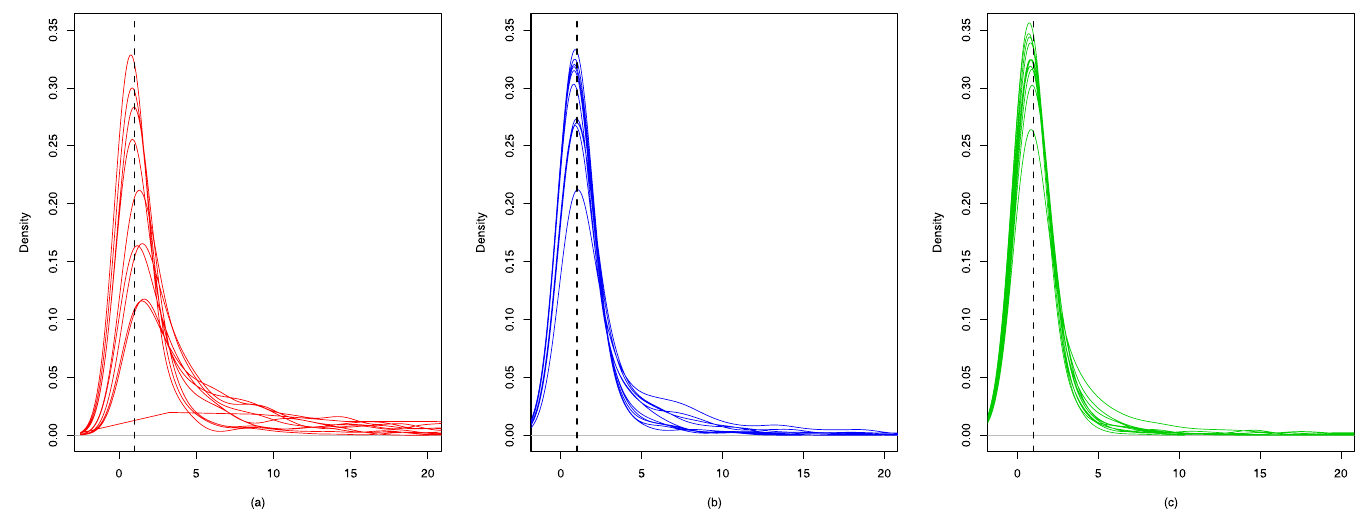
Fig 4. Density curves of the quotients between estimated and true popularity scales. (a) θ = 1.7; (b) θ = 2.0; (c) θ = 2.3.